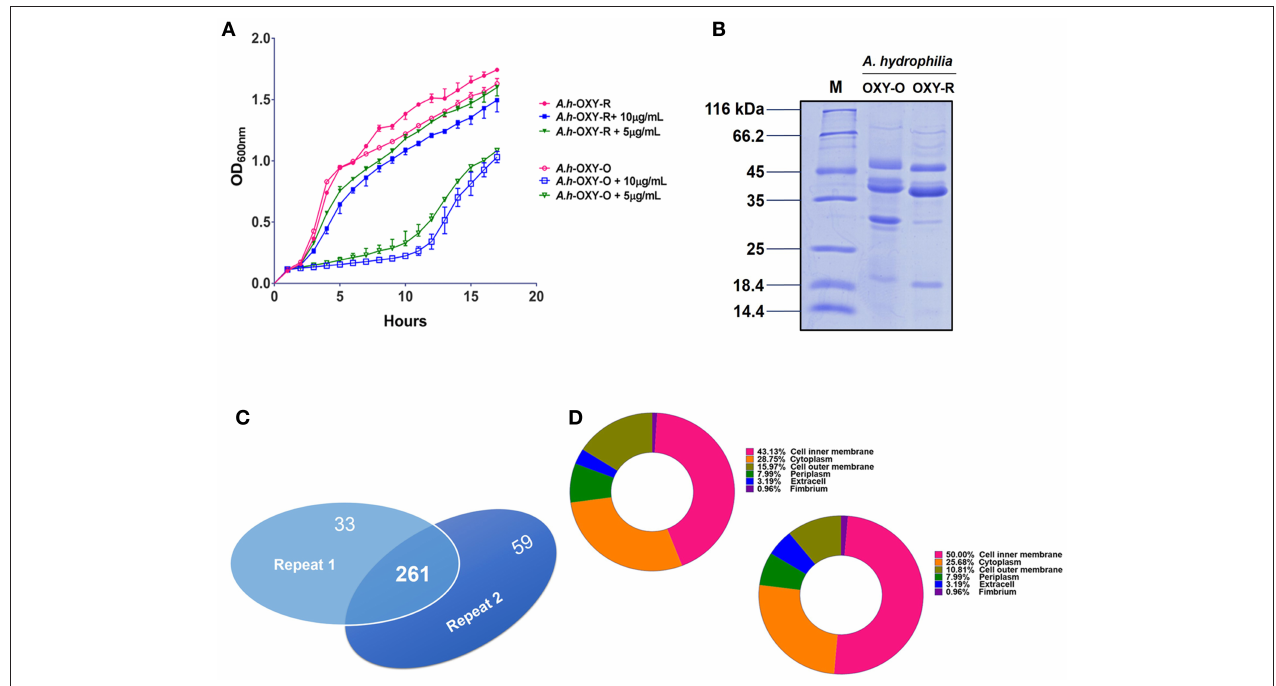
FIGURE 1 | Comparative analysis of OM fractions from A. hydrophila ATCC 7966 under OXY stress. (A) Growth curve of A.h -OXY-R and A.h -OXY-O at concentrations of 0, 5,10 µ g/mL; (B) Coomassie Blue-stained SDS-PAGE of OMPs in A.h -OXY-R and A.h -OXY-O, Lane M contains molecular mass standards; (C) Venn diagram showing overlap of the identified proteins by LC-MS/MS between two biological repeats in this study; (D) Prediction of subcellular localization of identified (left panel) and altered proteins (right panel) by online Gneg-multi-software.